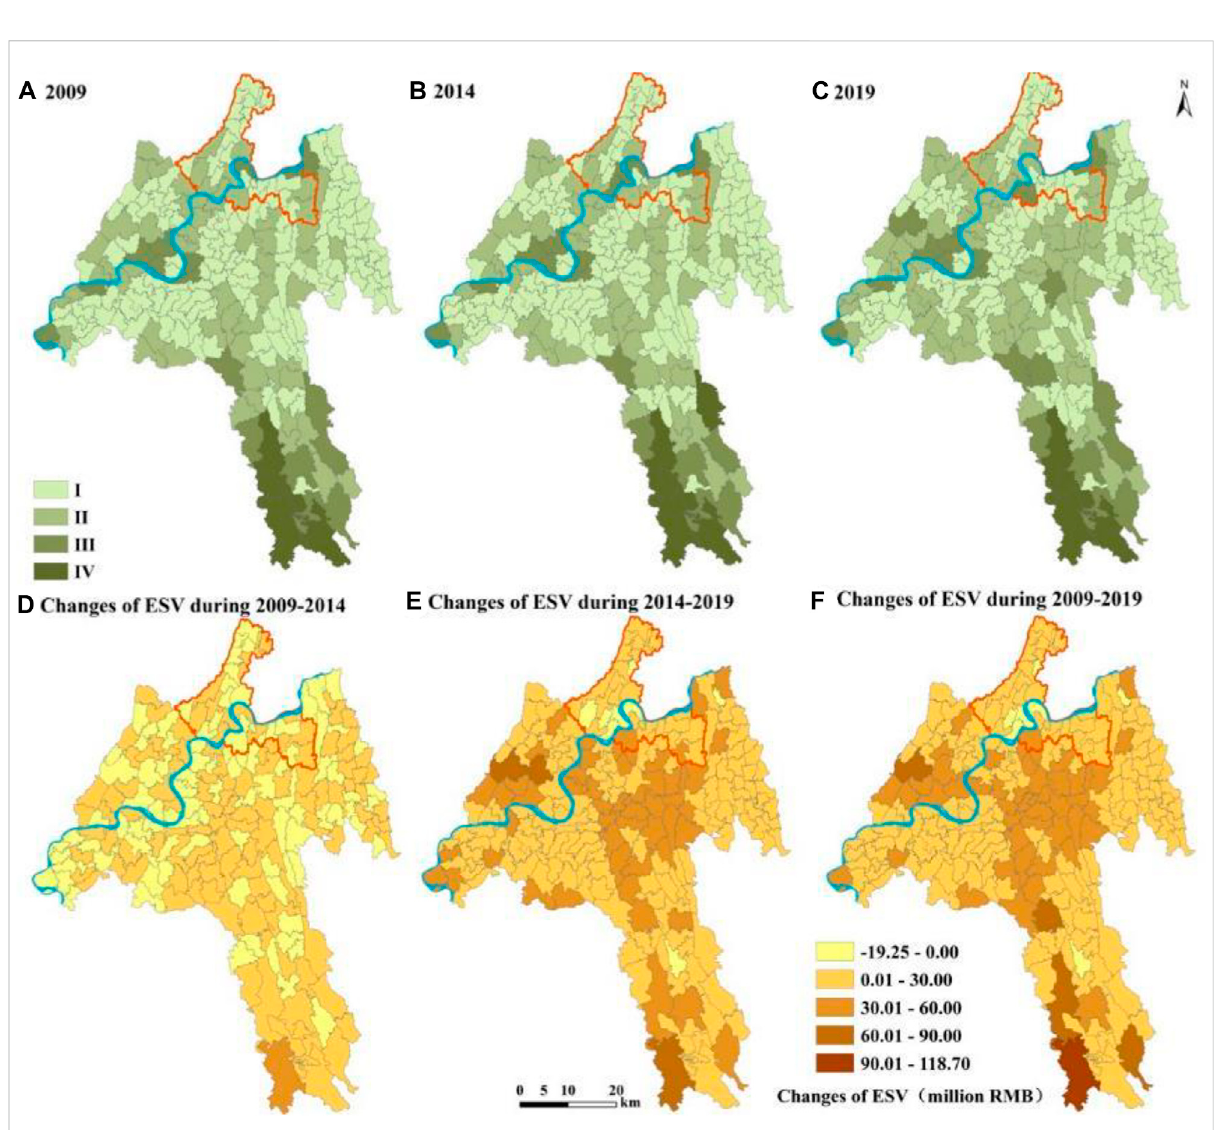
FIGURE 6 Spatial and temporal changes of ecosystem service in jiangjin from 2009 to 2019. (A – C) represent the grades of ecosystem service value in Jiangjinin2009,2014and2019,respectively; (D) :changeofecosystemservicevalueinJiangjinfrom2009to2014; (E) :changeofecosystemservice value in Jiangjin from 2014 to 2019; (F) : change of ecosystem service value in Jiangjin from 2009 to